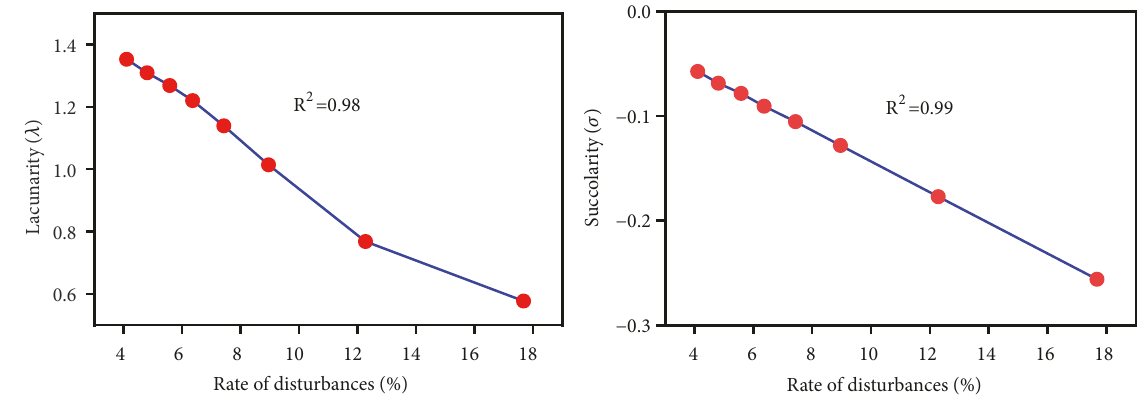
Figure 10: Summary of the Lacunarity and Succolarity values as a function of the disturbances